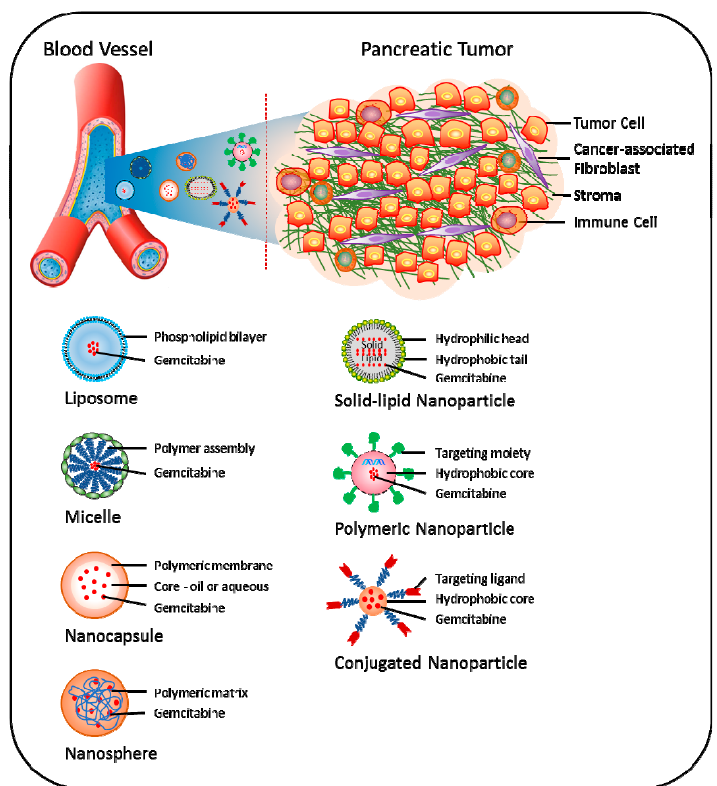
Figure 3. Approaches being explored to target pancreatic tumor using gemcitabine-based nanomedicines. Different nanocarriers, such as liposome, micelle, nanocapsule, nanosphere, polymeric nanoparticle, solid-lipid nanoparticle and conjugated-nanoparticle, have been developed for effective delivery of gemcitabine to pancreatic tumor cells. Strategies for the efficacy of gemcitabine using nanomedicines include, but are not limited to increased drug availability via protection from first-pass metabolism, passive accumulation at the tumor site due to the enhanced permeability and retention (EPR) effect, as well as targeted delivery of gemcitabine to tumor cells To bypass the rapid inactivation of gemcitabine, a novel squalene (SQ)-dFdC NP formulation